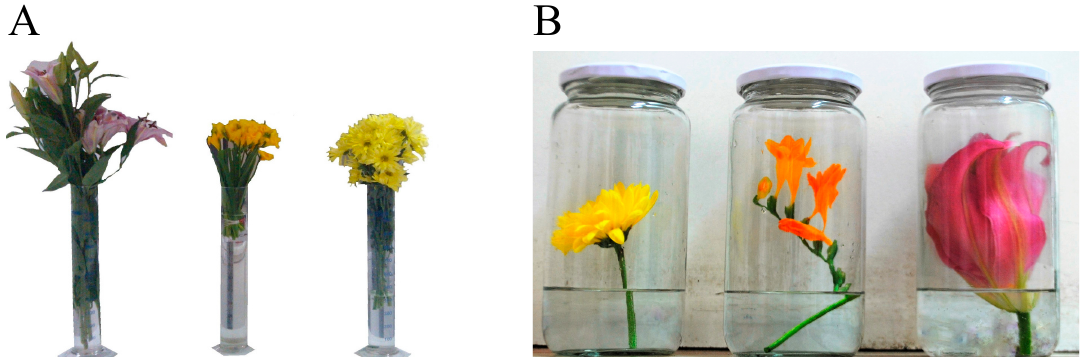
Figure 1. Flowers of oriental lily ( Lilium spp. cv. ‘Sweetness’), freesia ( Freesia x hybrid cv. ‘Oberon’), and chrysanthemum ( Chrysanthemum spp. cv. ‘Marble’) (from left to right) used for the sensorial analysis ( A ) and GC-MS analysis ( B